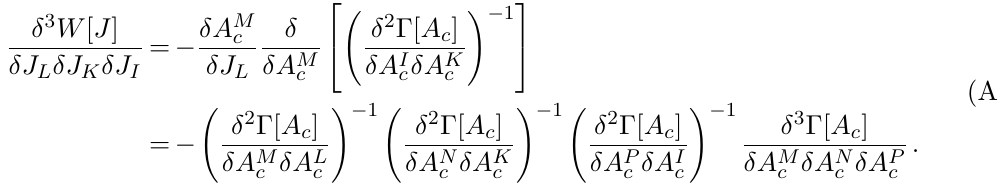
] (A.1). We see that the third c JHEP11(2022)132